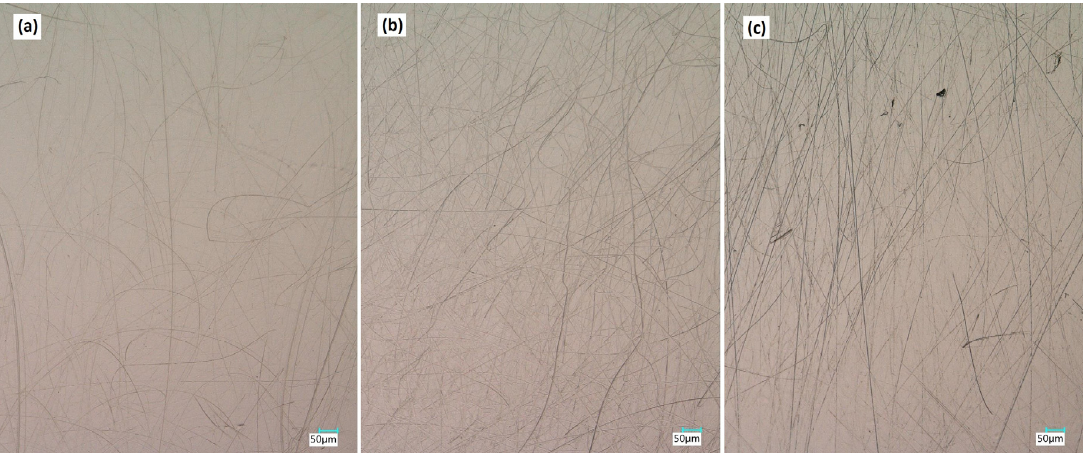
Figure 3. Representative examples of light optical images of the metal femoral heads at a magnification ×200. ( a ) Spacer with metal-on-cement articulation, ( b ) conventional hip arthroplasty with metal-on-polyethylene articulation, and ( c ) conventional hip arthroplasty with metal-on-metal articulation.